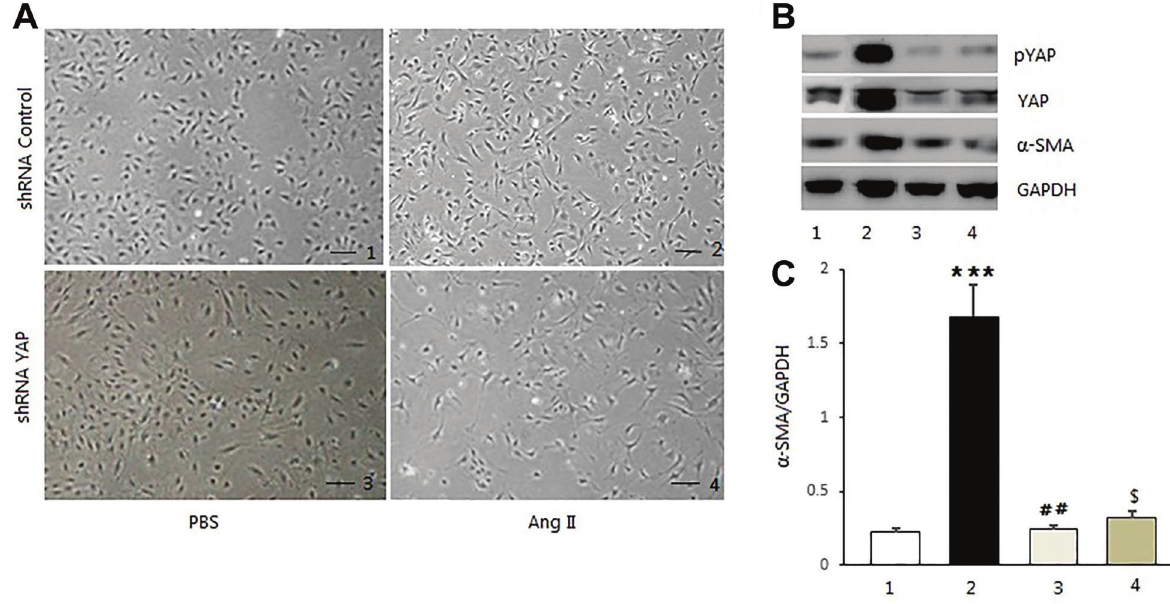
Figure 2. Angiotensin II (Ang II) activated Yes-associated protein (YAP) in cardiac myo fi broblast transdifferentiation. A – C , The expression of YAP was signi fi cantly decreased by infecting lentiviral shRNA targeting YAP. Scale bar: 50 m m. Data are reported